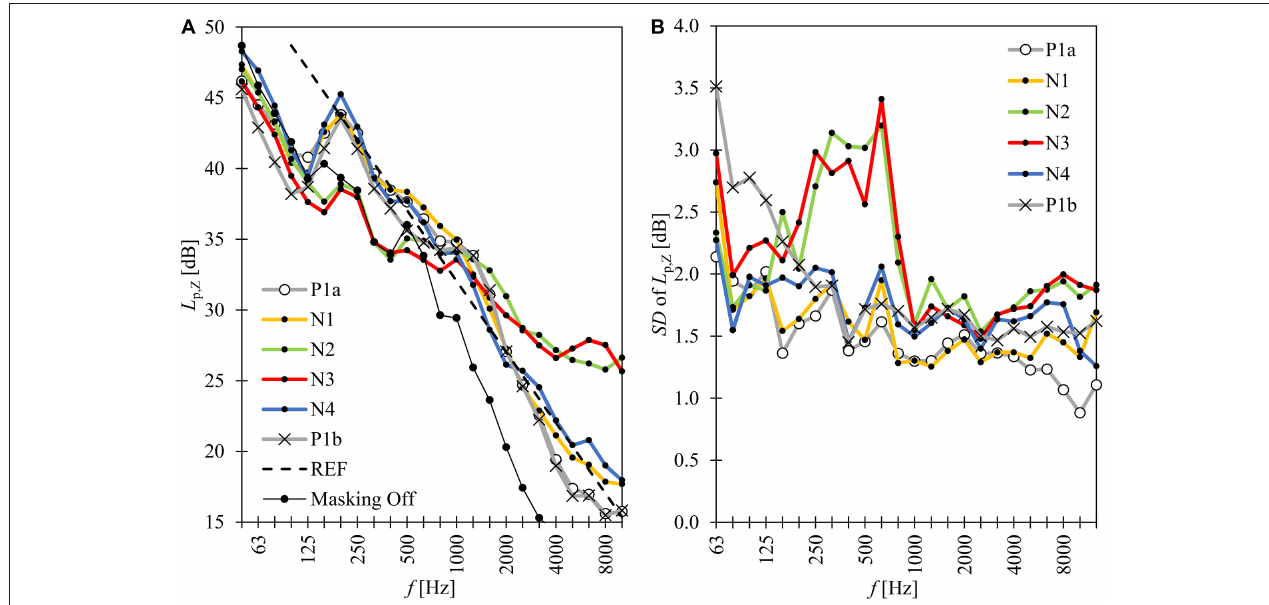
FIGURE 1 | The measured spectra of the masking sounds over the 54 workstations. (A) Mean value and (B) standard deviation ( SD ). REF represents the slope − 5 dB per octave doubling at a level of 44 dB L Aeq . Masking Off corresponds to ventilation noise.